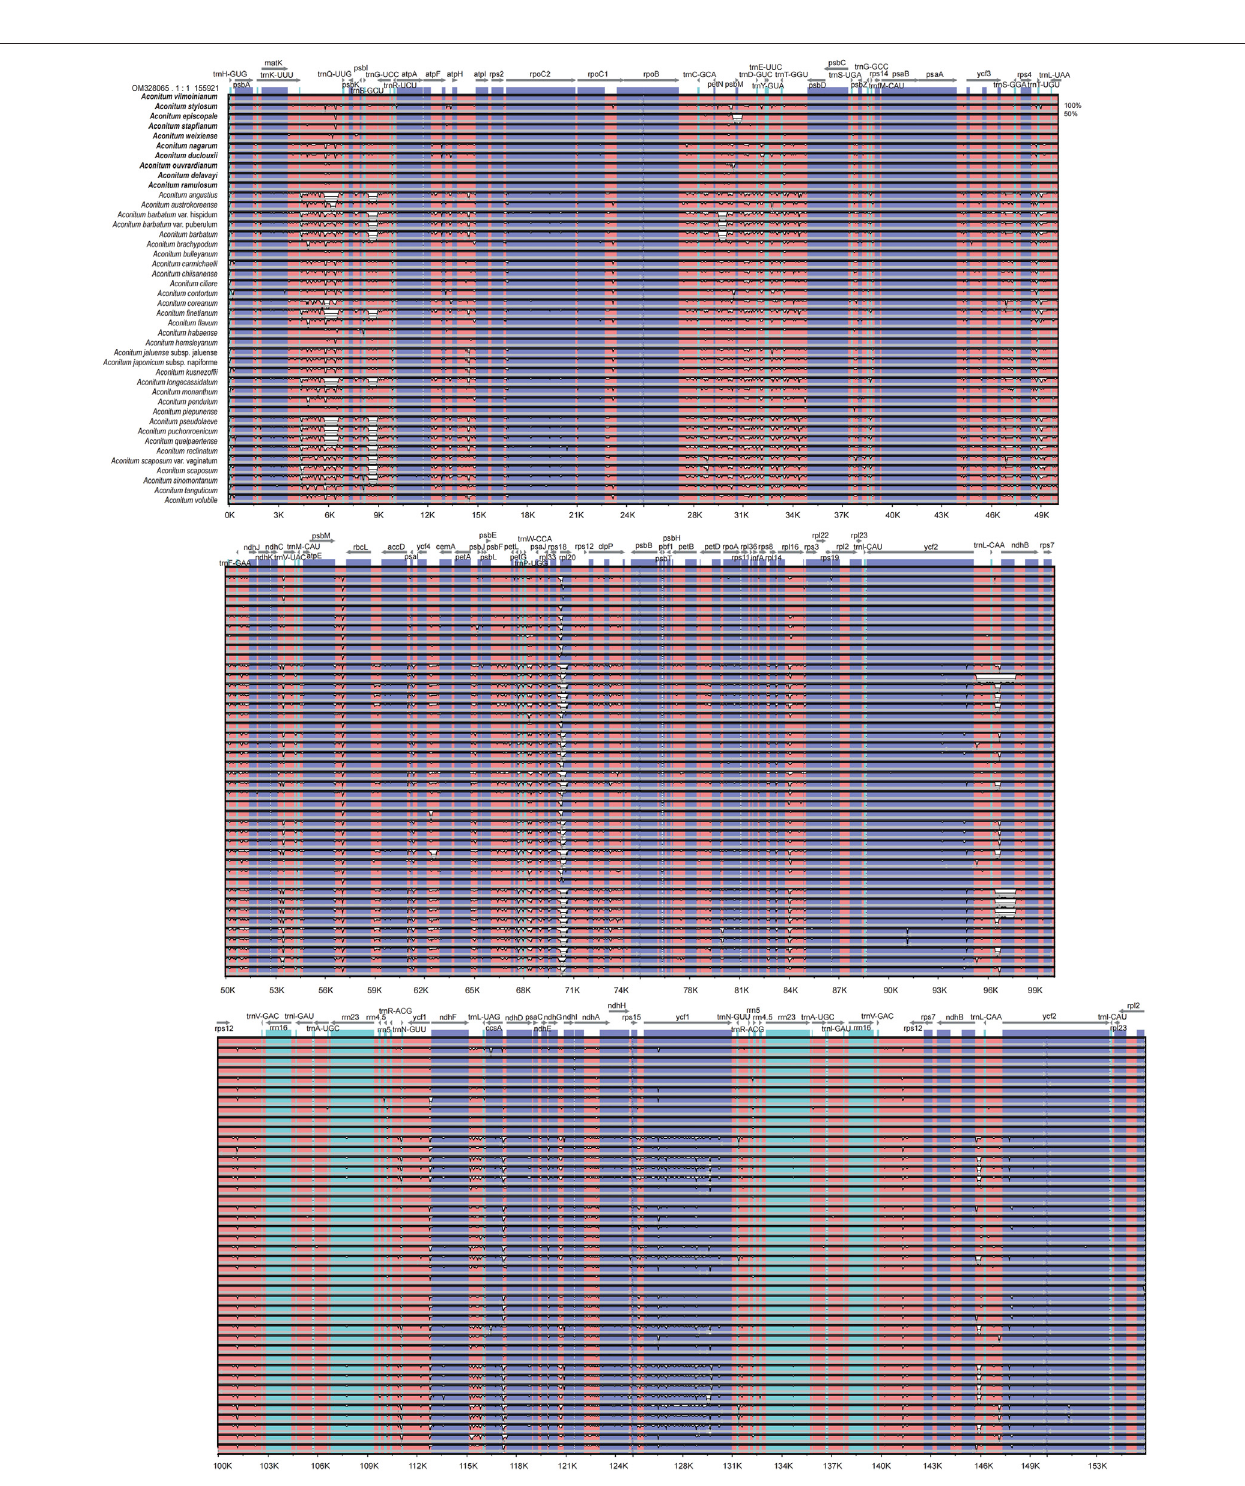
FIGURE 9 | Global chloroplast genome alignments for 42 Aconitum species using the mVISTA program, with A. vilmorinianum as the reference. Y-axis shows the range of sequence identity (50 – 100%).